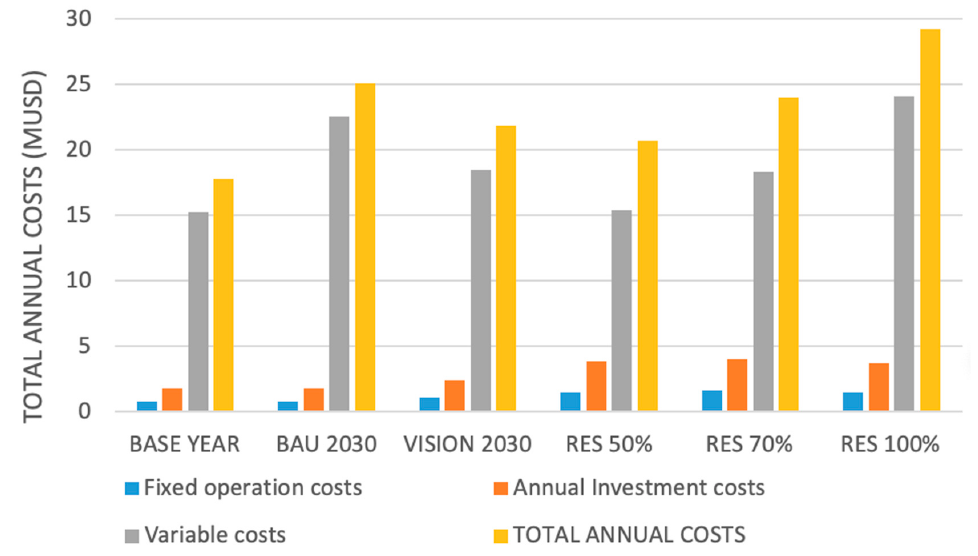
Figure 14. Total annual costs (MUSD) in 2019 and in 2030.